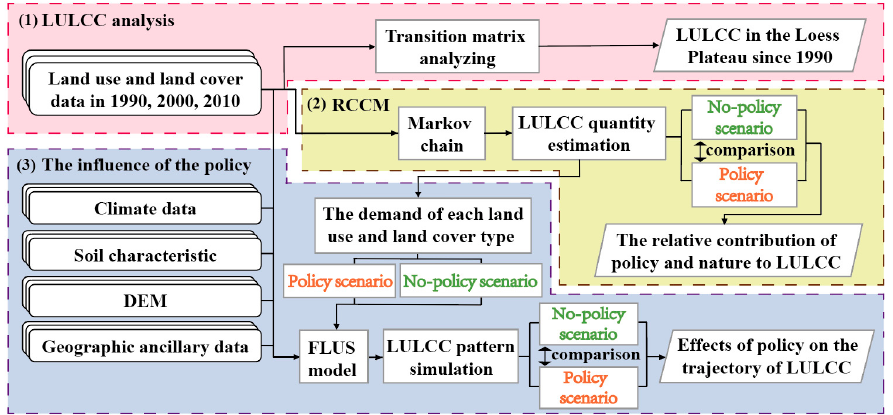
Figure 3. Flowchart of the research methods. LULCC refers to land use and land cover change. RCCM is the relative contribution conceptual model. No-policy scenario: a scenario where the LULCC is less affected by the policy intervention (GFGP). Policy scenario: a scenario where the LULCC is affected by the normal background change and the policy (GFGP).